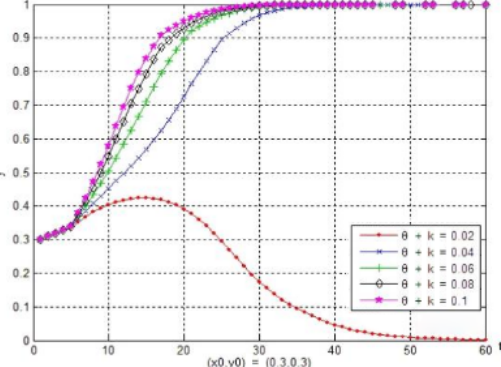
Figure 5. The influence of ( θ + k) change on the probability of enterprise construction waste emissions reduction, y.